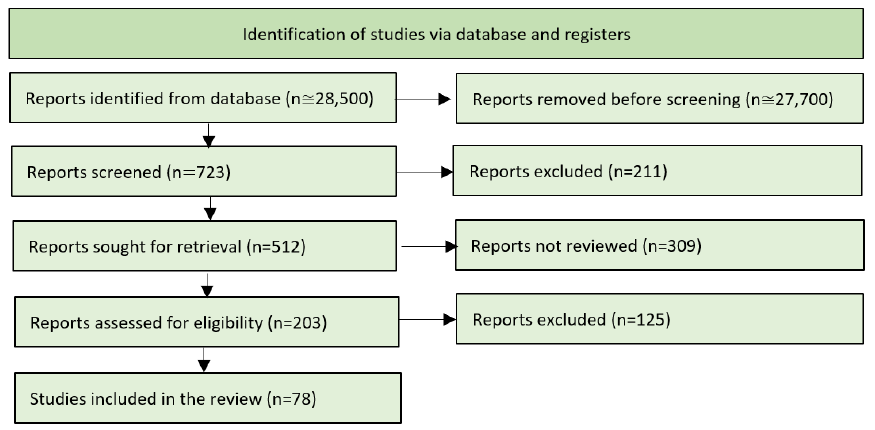
Figure 1. PRISMA flow diagram for this systematic review .